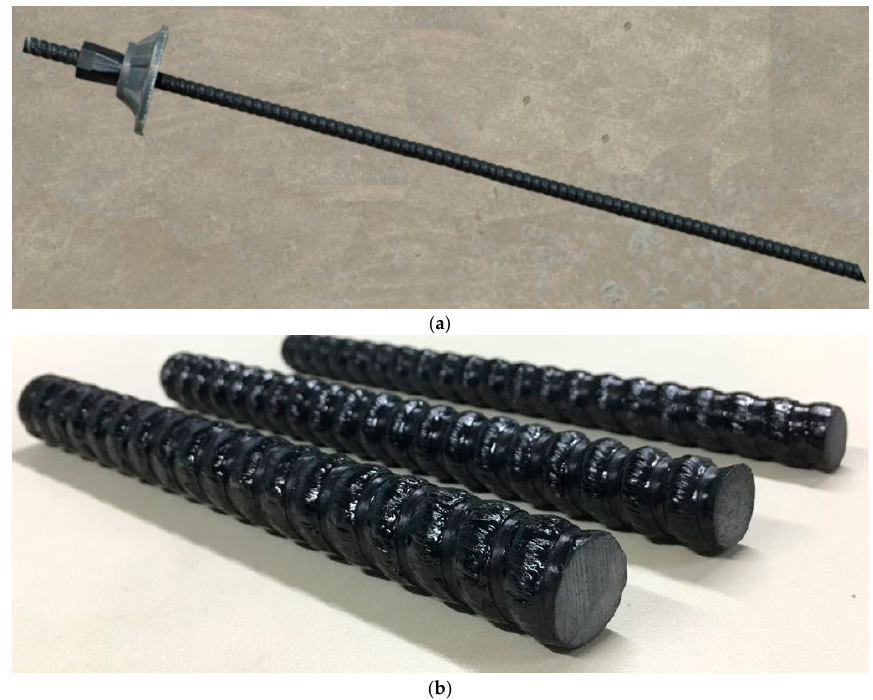
Figure 4. ( a ) A fiberglass reinforced plastic (FRP) bolt; ( b ) detail of the FRP bolt.